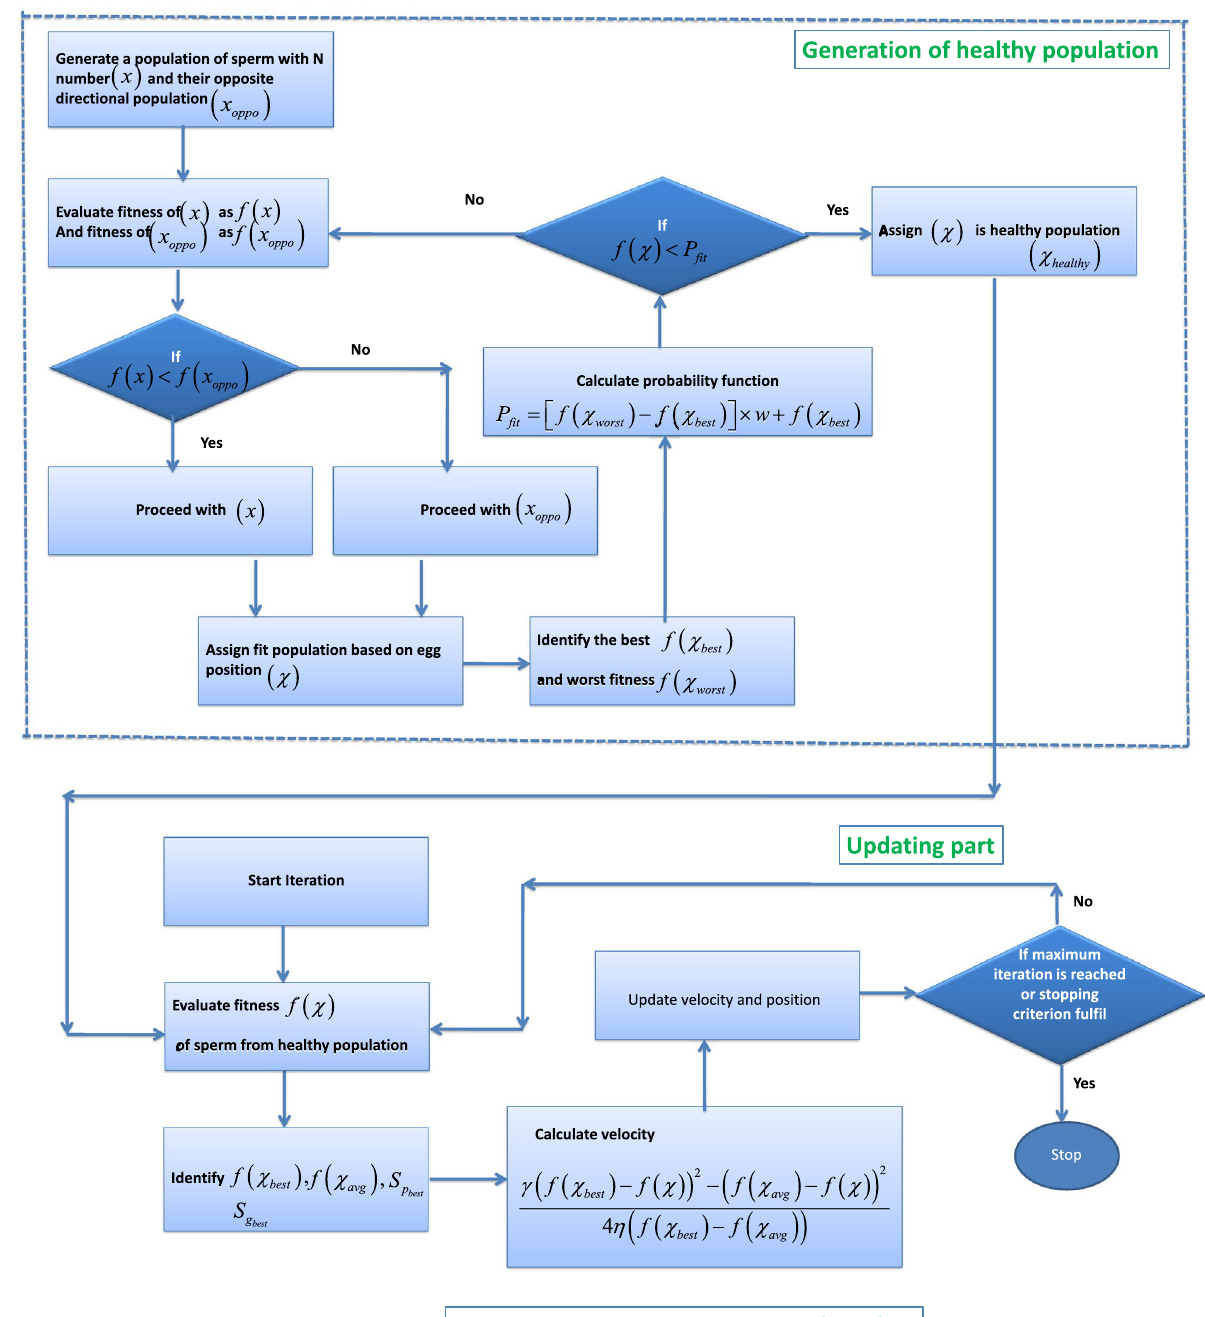
Figure 3. Flowchart of proposed HCO